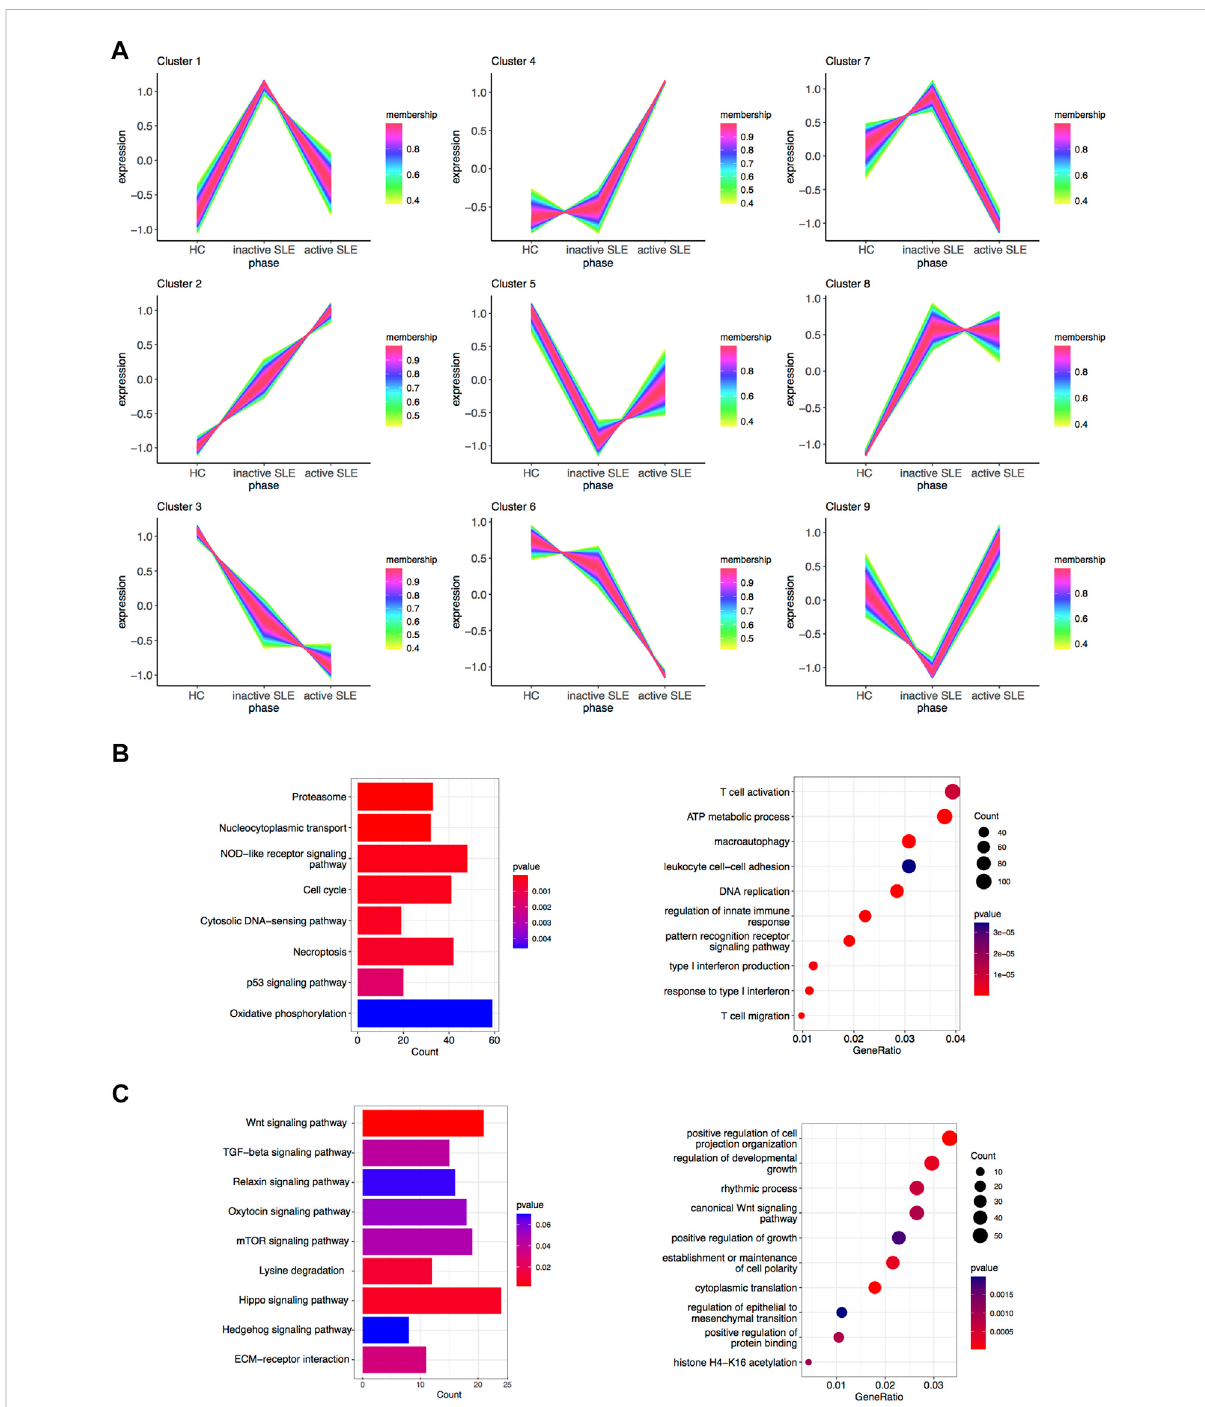
FIGURE 4 Identi fi cation of gene sets related to SLE disease activity. (A) Clustering of the gene expression patterns in CD4 + T cells from HC, inactive and active SLE patients by TCseq analysis. A totalof 9 clusters were obtained and the Cluster 2 and 3 werefound signi fi cantly correlated with SLE disease activity. (B) KEGG (left) and GO (right) analysis of genes in the Cluster 2. (C) KEGG (left) and GO (right) analysis of genes in the Cluster